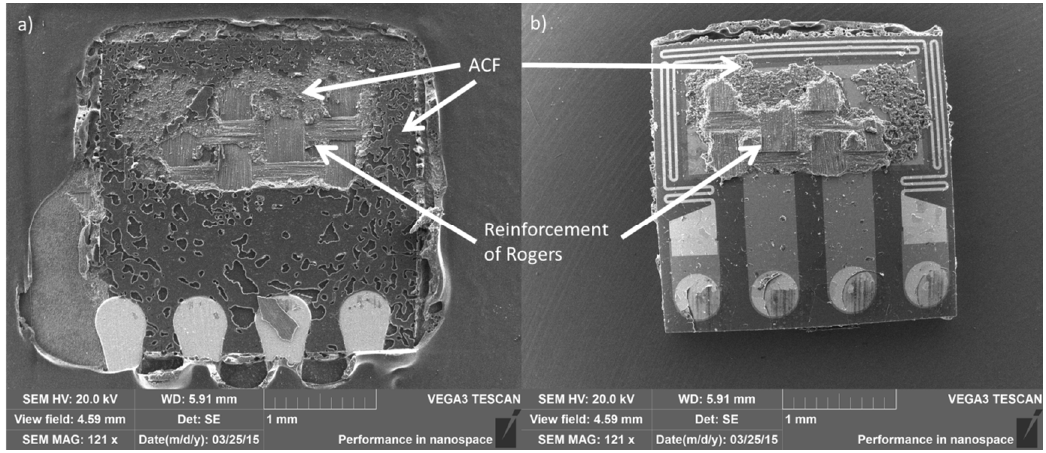
Figure 16. SEM images showing the fracture surface of ( a ) Rogers PCB; ( b ) chip aged for 120 h at 200 °C.